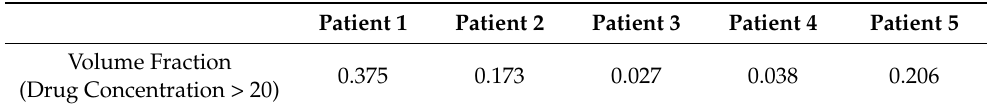
Table 4. Fraction of the tumor that receives a drug concentration greater than 20 (dimensionless units) for the 5 patients at day 43 of the